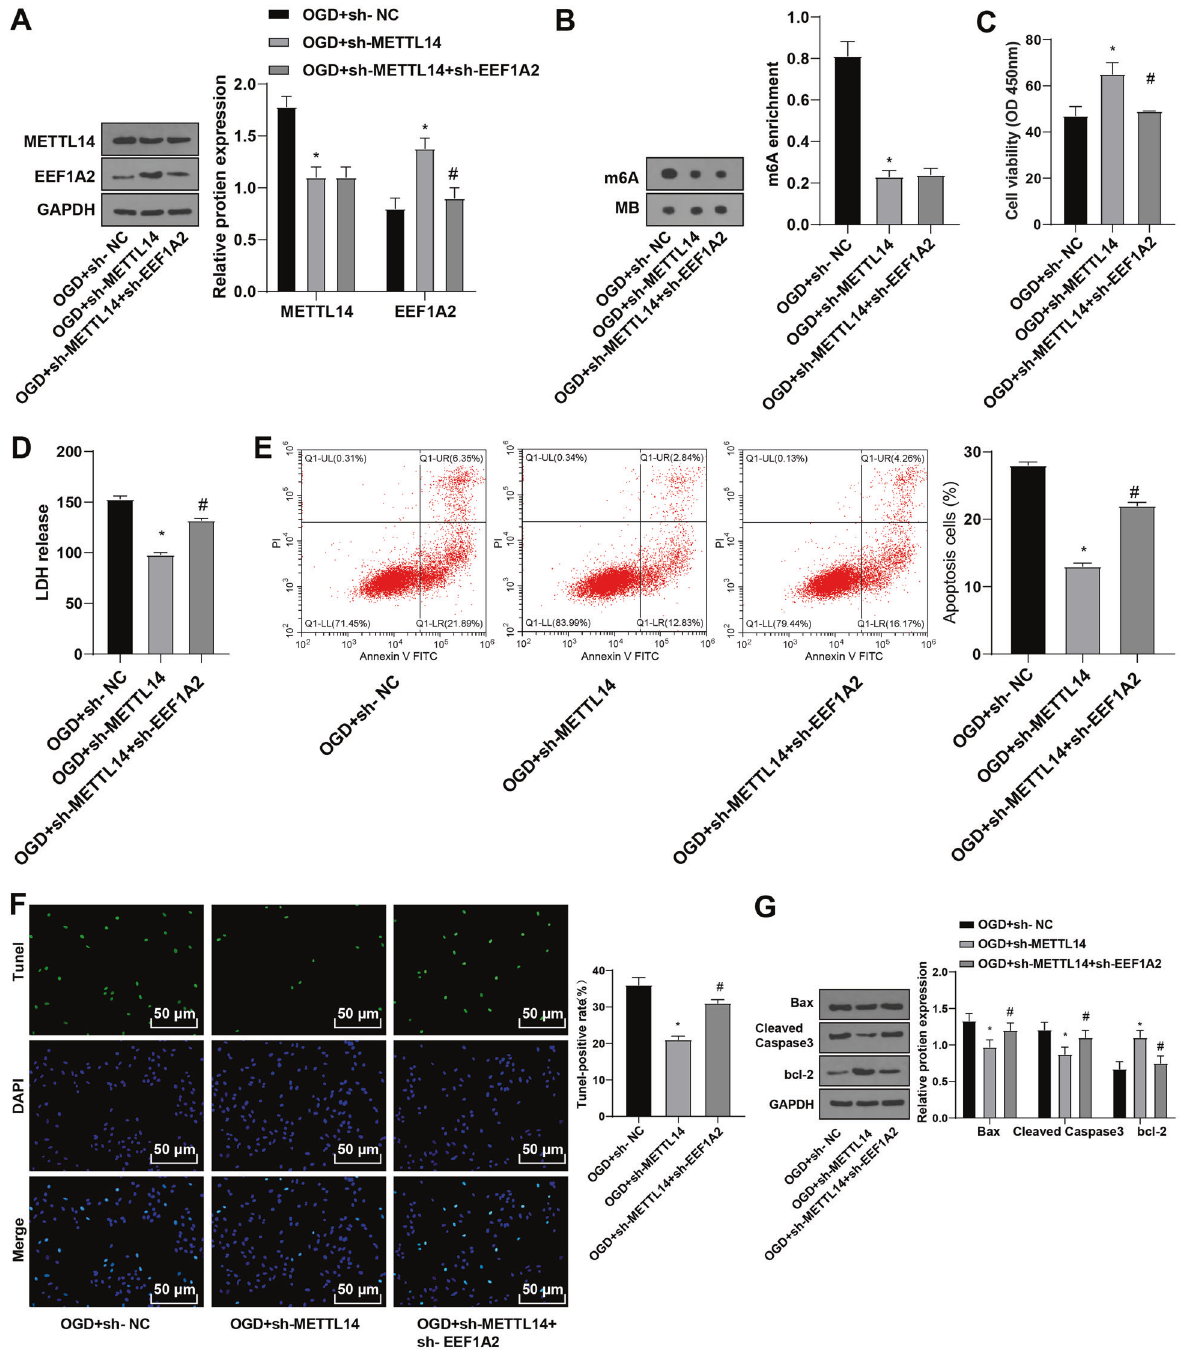
Fig. 5 Mettl14 modulated the function of H/R-treated spinal cord neurons by mediating EEF1A2. A expressions of Mettl14 and EEF1A2 in neurons detected by Western blot; ( B ) total m6A level detected by Dot blot assay; ( C ) neuronal viability detected by CCK-8; ( D ) cell toxicity assessed by LDH release assay; ( E ) neuronal apoptosis detected by fl ow cytometry; ( F ) neuronal apoptosis detected by TUNEL staining; ( G ) expressions of Bax, cleaved caspase3 and bcl-2 detected by Western blot. Data were expressed as mean ± SD and analyzed using independent t test. The experiment was repeated three times. * vs OGD + sh-NC group, p < 0.05; # vs OGD + sh-Mettl14 group, p <